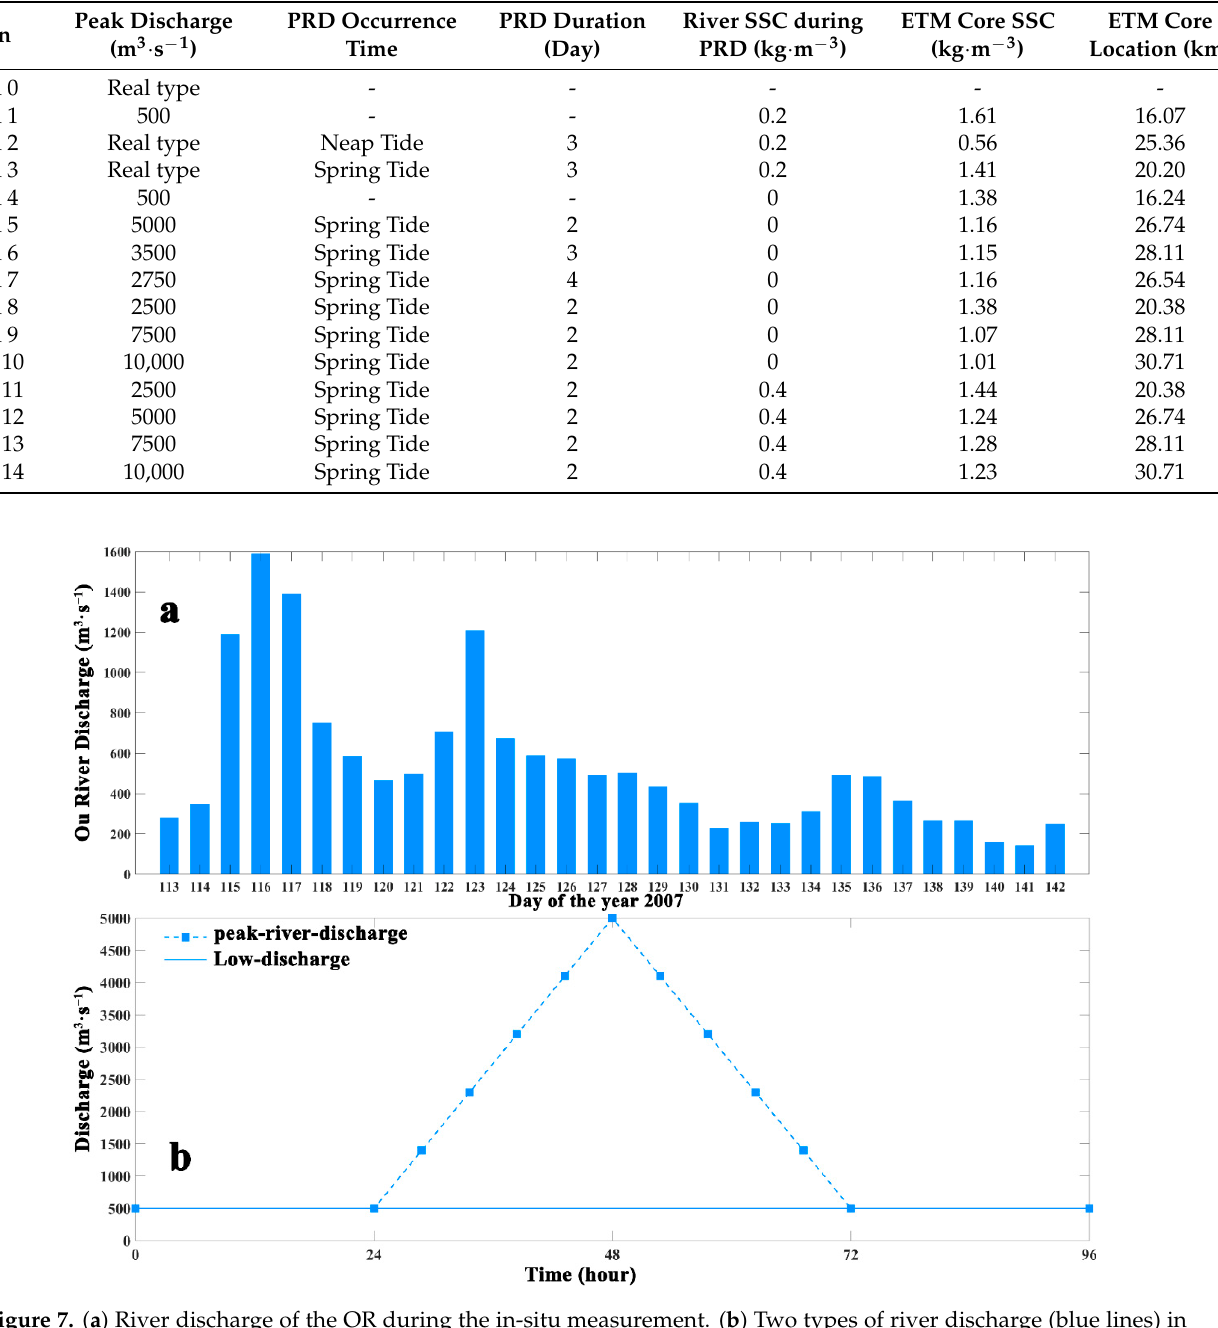
Table 4. Experiment configuration and the SSC and location of the ETM core in the along-channel section (the red line in Figure 1b with the red triangle indicating 0 km).